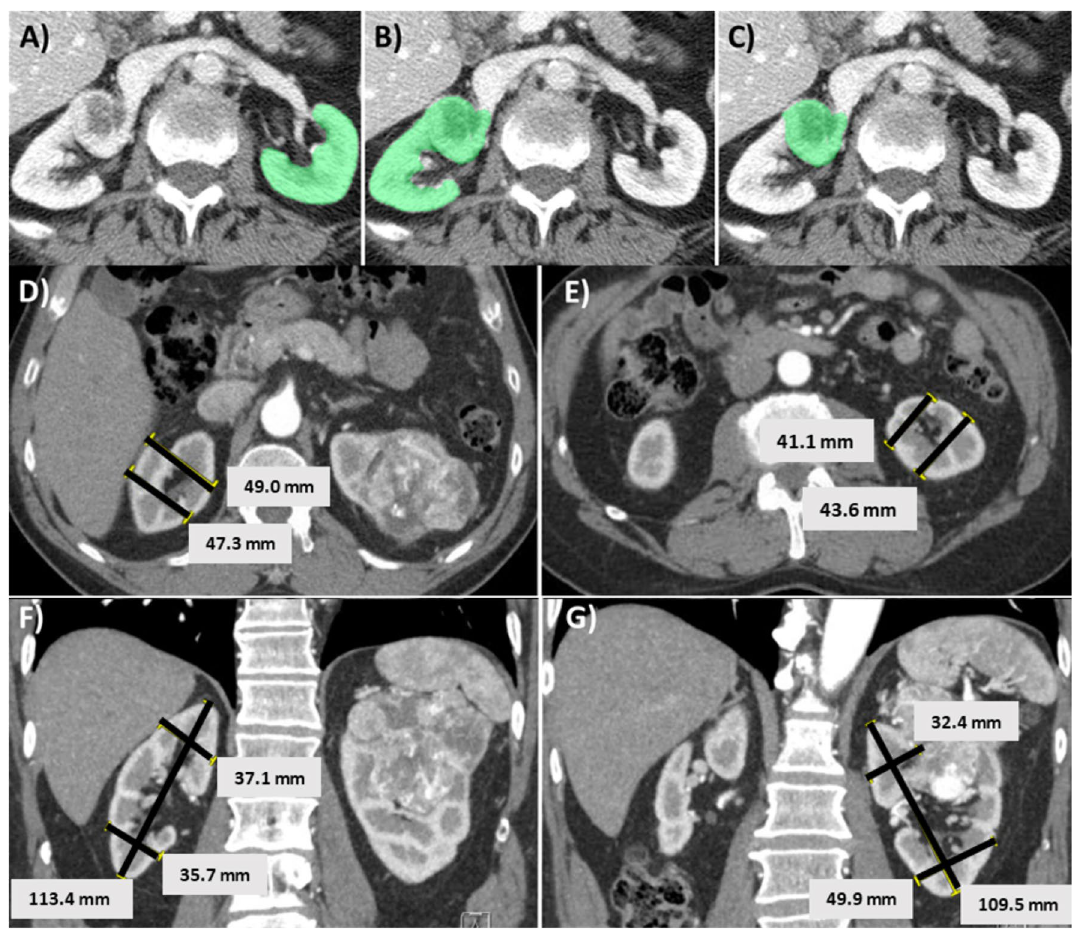
Figure 2. Software-derived parenchymal volume analysis (PVA) and linear length–width-height (LWH) measurements for calculating split renal function (SRF). ( A – C ) Software-based parenchymal volume analysis (PVA) of the ( A ) contralateral kidney (tumor-free); ( B ) ipsilateral kidney with tumor; and ( C ) tumor alone. In this case the left renal parenchymal volume was 210 cm 3 , the volume of the right renal parenchyma plus tumor was 229 cm 3 , and the tumor volume alone was 39 cm 3 . The parenchymal volumes were thus 210 cm 3 (L) and 190 cm 3 (R), and the estimated SRF was 53% (L) and 47% (R). ( D , E , F , G ) Linear length/width/height (LWH) measurements showing two anterior–posterior measurements (axial; D , E ), and one length and two medial–lateral measurements (coronal; F , G ) for each kidney. All measurements were obtained in cross- sectional images with maximal visible parenchyma, with exclusion of tumor and central sinus. Anterior– posterior and medial–lateral measurements were taken at the level of the polar line 15 . Parenchymal volumes were calculated as 0.52 × Length × (Average of anterior–posterior) × (Average of medial–lateral). In this example, the contralateral (tumor-free) kidney had a parenchymal volume of 0.52 × 11.3 cm (length) × 4.8 cm (anterior– posterior average) × 3.6 cm (medial–lateral average). The ipsilateral (tumor-bearing) kidney was 0.52 × 11 cm (length) × 4.2 cm (anterior–posterior average) × 4.1 cm (medial–lateral average). The relative parenchymal volumes were thus 98.5 cm 3 (L) and 101.5 cm 3 (R), and the estimated SRF was 49% (L) and 51% median tumor volume was 104 cm 3 . Median postoperative NBGFR was 47 ml/min/1.73 m 2 , with a median RFC of 1.26 (26% compensatory hypertrophy) observed in the contralateral kidney. Figure 3A,B,C show the correlations between predicted and observed NBGFR for the various methods for obtaining SRF. Correlation coefficients ( r ) were strong for the software-derived PVA approach ( r = 0.86) and moderate for the LWH- and NRS-based approaches ( r = 0.72 and 0.71, respectively). These differences were sta- tistically significant ( p < 0.03, Table 2). Software-derived PVA also demonstrated improved performance in terms of bias, precision, mean-squared error, and accuracy. Supplemental Figure 1 shows the ROC analyses that evaluate the abilities of each of the three methods in terms of discriminating postoperative NBGFR > 45 ml/min/1.73 m 2 . AUC values for the LWH, NRS, and software-derived PVA approaches were 0.72, 0.76, and 0.82, respectively.